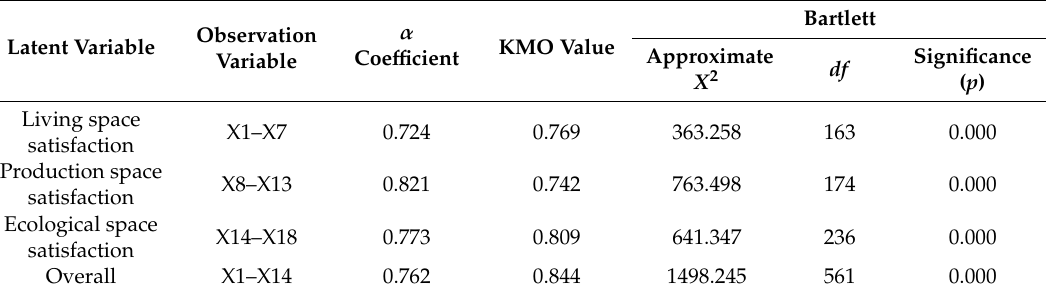
Table 2. Reliability and validity analysis.